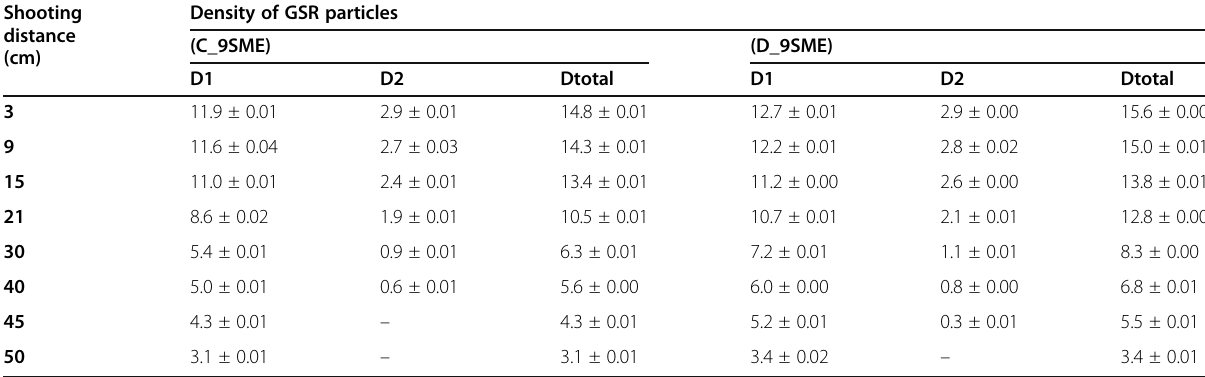
Table 2 Density of GSR particles vs. shooting distance data for (C_9SME) and (D_9SME) pistol at different shooting distances Shooting distance